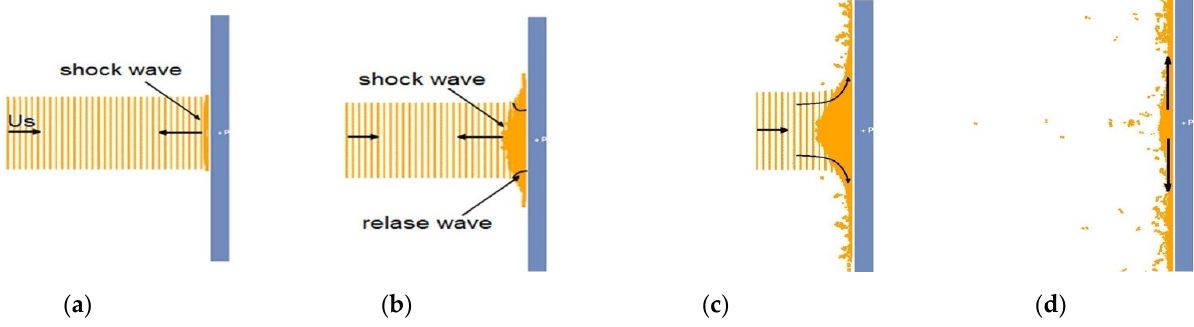
Figure 1. Phases of bird impact process. Adapted from Ref. [25].